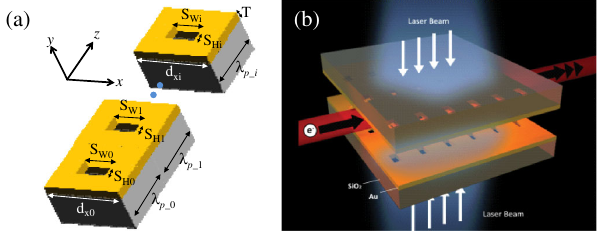
FIG. 1. (a) Schematic of a single row of slot antenna unit cells in the metasurface; (b) schematic of the MLA formed by two parallel metasurfaces, symmetrically driven by cophased laser pulses incident from the top and